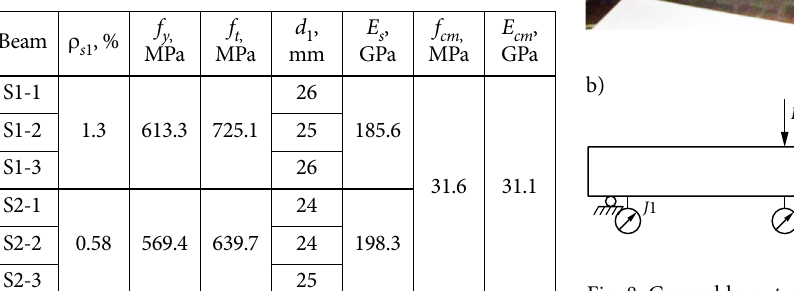
Fig. 8. General layout of the measuring instruments: a) picture (upside down); b) scheme: I 1 -I 3, J 1 -J 5 – electromechanical indicators; T 1 -T 4 – strain